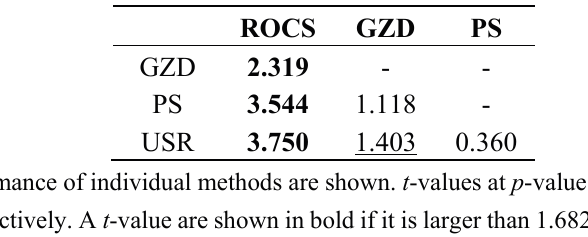
Table 2. Pairwise student t -test between pairs of the